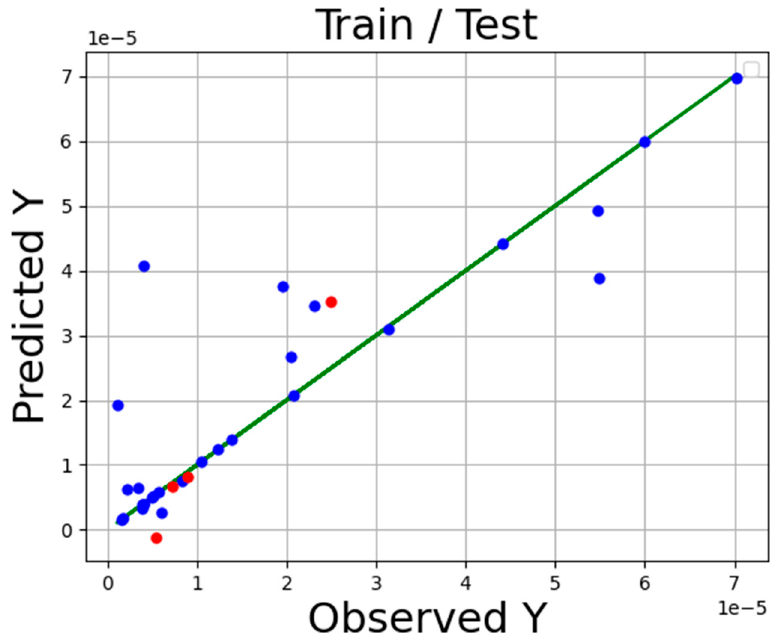
Figure 3. Fitting chart for ADA ‐ TSR.